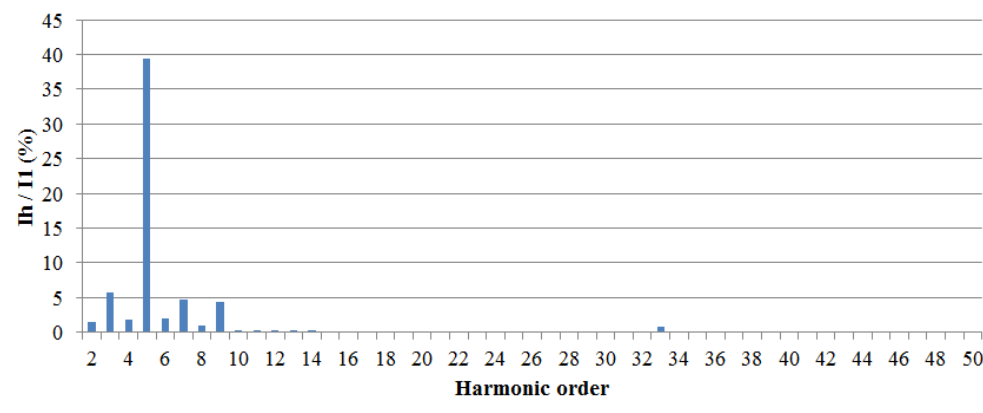
Figure 13. Current harmonic components at the point of common coupling (PCC) when the system becomes unstable, owing to the connection